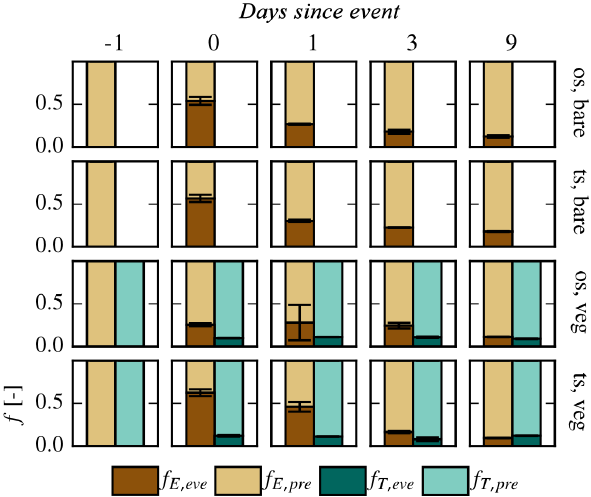
Figure 6. Mean daily fractions f of event water (eve) and pre-event water (pre) in soil evaporation E and plant transpiration T from bare-soil (bare) or vegetation plots (veg) at open sites between tree crowns (os) and shaded sites beneath tree crowns (ts). Numbers at the top mark days after watering event. Uncertainty bars display standard error.